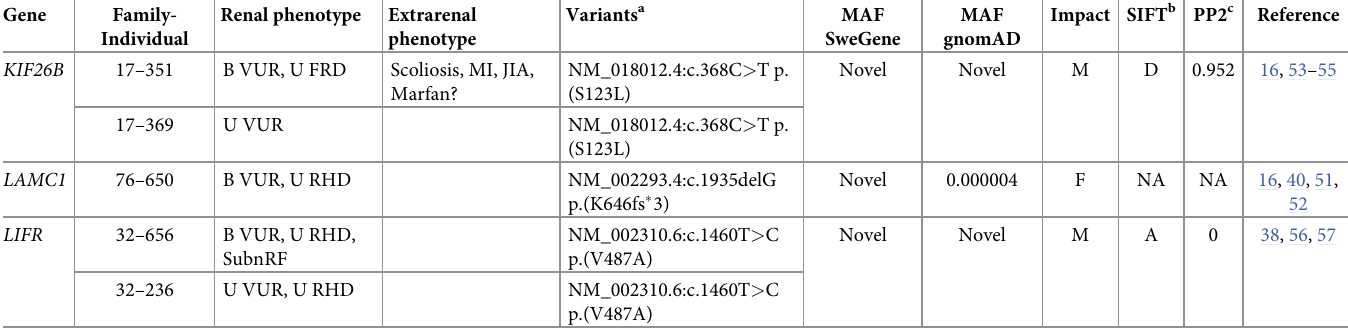
Table 3. Three possibly pathogenic variants identified in nephrogenesis-related genes in three families with hereditary VUR. Gene Family-